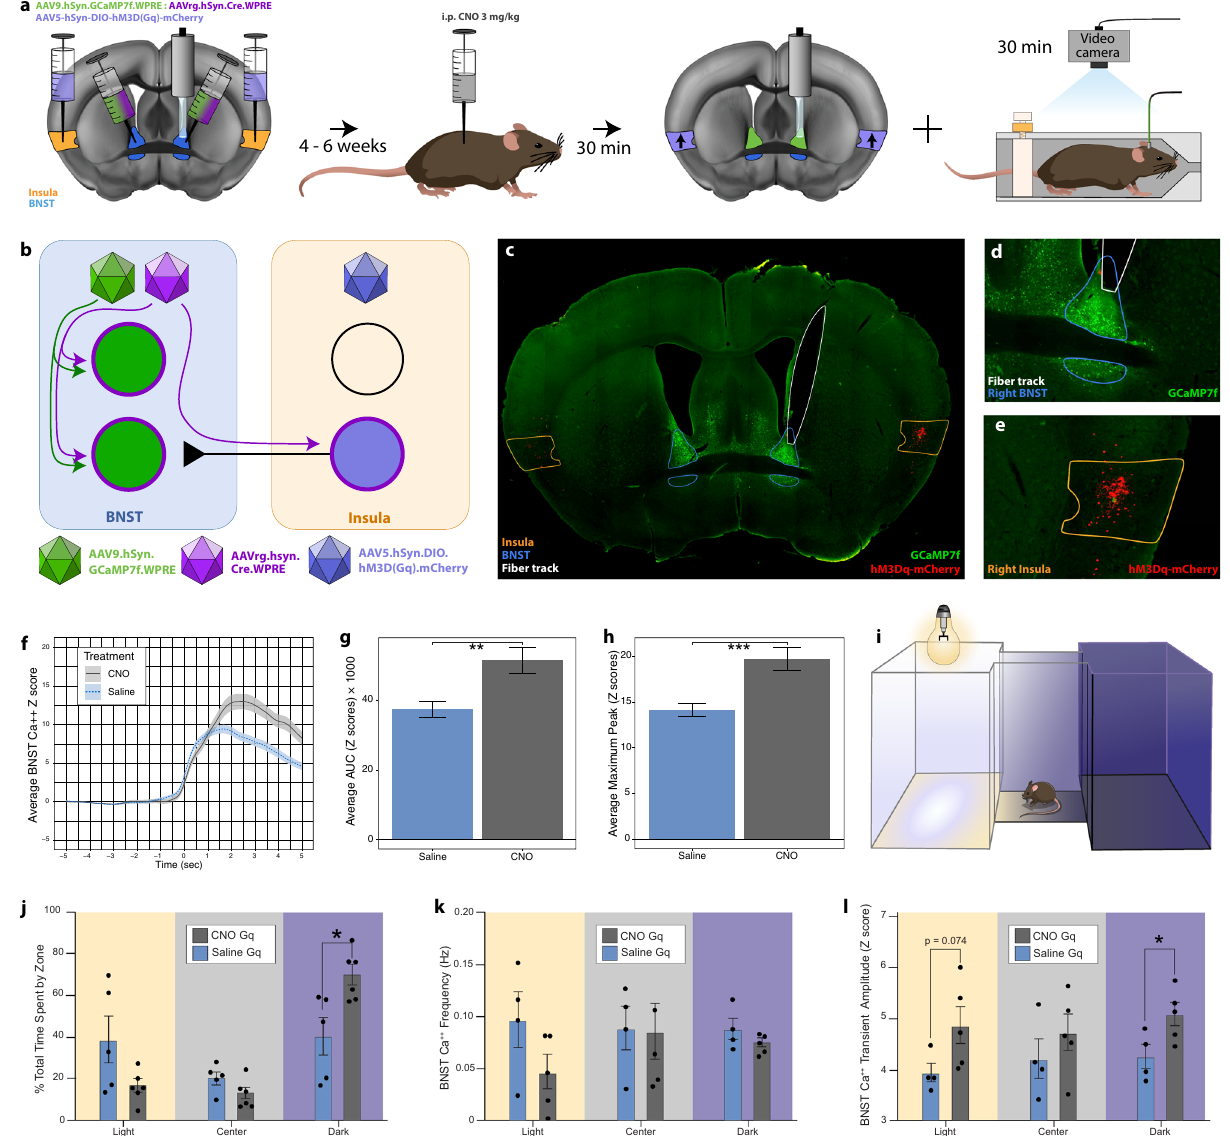
Fig. 5 Chemogenetically activating insula → BNST cells increases struggling bout-associated BNST calcium transients and anxiety-like behavior after restraint. a , b Schematics. c Representative coronal slice. Fluorescent channels: GCaMP7f (green) and hM3Dq-mCherry (red); outlines: BNST (blue), insula (orange), and fi ber track (white). d , e Respective injection sites. d Right BNST. e Right insula. f BNST calcium transient time-locked to struggling onset. (CNO = gray, saline = blue). g Area under the curve (AUC) of Z scores from all bouts of CNO- (gray) and saline (blue)-treated animals. Welch two- sampled t test, t (494.56) = 3.1668, ** P = 0.0016. h Average maximum peak Z score from all bouts of CNO- (gray) and saline (blue)-treated animals. Welch two-sampled t test, t (467.1) = 3.9858, *** P = 0.0008. g , h CNO: n = 813 bouts from fi ve animals. Saline: n = 910 bouts from six animals. i Diagram of light – dark box with three zones (light, center, and dark). Mice were placed in the center chamber of the light – dark box for 10 min following restraint testing. j Percent of total time spent in each zone (light, center, and dark) by CNO- ( n = 5) and saline ( n = 5)-treated animals. Multiple unpaired t tests with the false discovery rate (FSD) approach of two-stage step-up method of Benjamini, Krieger, and Yekutieli. FSD = 1%. light zone: t (8) = 1.833, P = 0.104; center zone: t (8) = 1.463, P = 0.1814; dark zone: t (8) = 2.636, * P = 0.0299. k BNST calcium transient frequency in each zone (light, center, and dark) by CNO- ( n = 5) and saline ( n = 4)-treated animals. Multiple unpaired t tests with the FSD approach of two-stage step-up method of Benjamini, Krieger, and Yekutieli. FSD = 1%. light zone: t (7) = 1.660, P = 0.1410; center zone: t (7) = 0.0965, P = 0.9258; dark zone: t (7) = 1.255, P = 0.2499. l Average BNST calcium transient amplitude in each zone (light, center, and dark) by CNO- ( n = 5) and saline ( n = 4)-treated animals. Multiple unpaired t tests with the FSD approach of two-stage step-up method of Benjamini, Krieger, and Yekutieli. FSD = 1%. light zone: t (7) = 2.096, P = 0.0743; center zone: t (7) = 0.9764, P = 0.3614; dark zone: t = 2.527, * P = (7) from those observed in the insula and BNST, as an increase in calcium signaling in motor → insula cells preceded the bout onset (Fig. 9d, e). The signal then returned to baseline before signi fi cantly increasing again shortly after the bout onset. As opposed to the insula signals, the maximum peak occurred several seconds after the